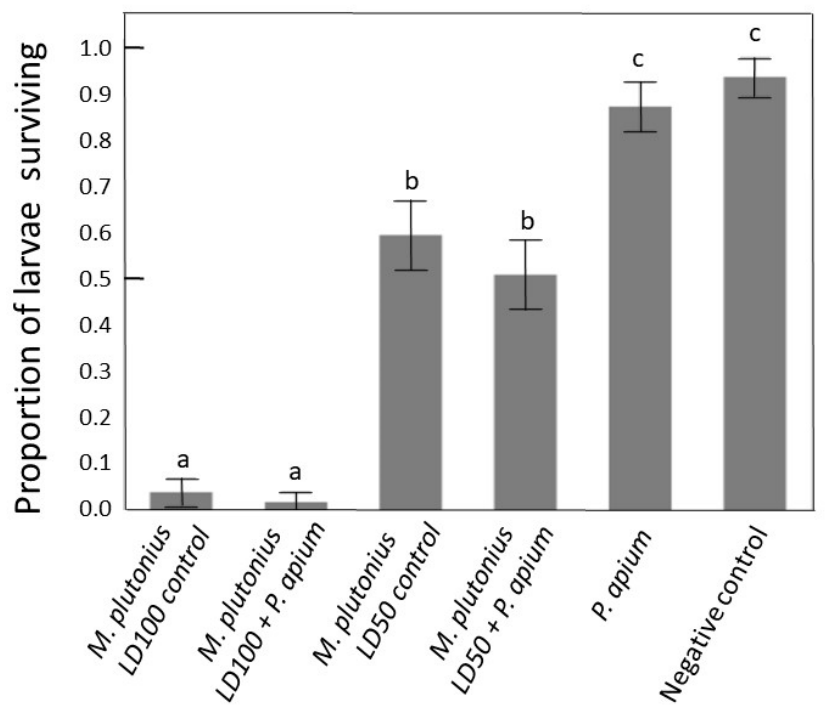
Figure 3. Proportion of larvae surviving M. plutonius challenge and P. apium rescue. Error bars represent two independent trials (see methods). From Figure 1, LD100 represents (6.4 CFU/µL) of M. plutonius AF5, and LD50 is (0.64 CFU/µL) killing approximately 50% of the larvae by 6 days of age. P. apium was introduced at 3 CFU/µL, the concentration used in Corby Harris et al. [20]. Columns with the same letter do not differ for larval survival.